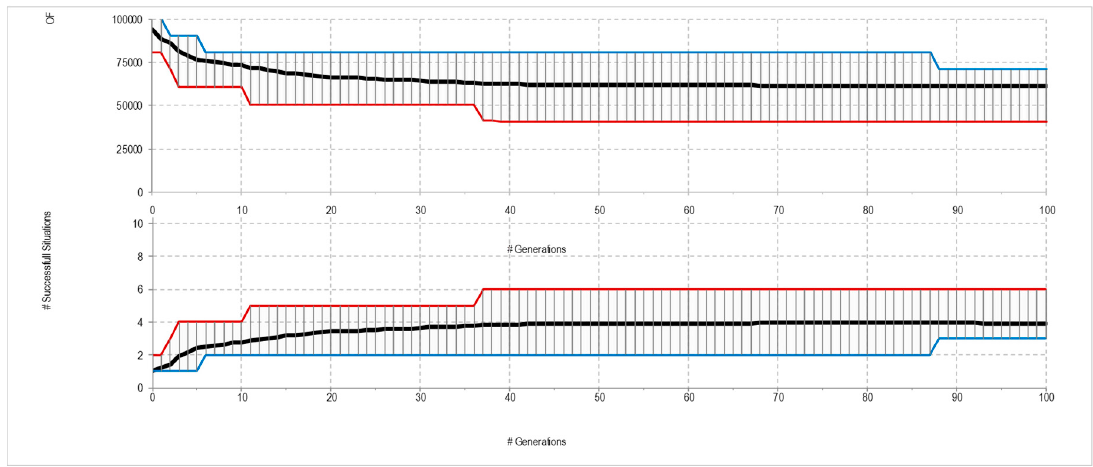
Figure 3. Convergence of the values of best objective function (OF, top ) and the number of successful situations ( bottom ) of 32 independent runs of the GA evolving the behavior of a team of predator agents with canonical morphology. The bold curves correspond to the mean, while the envelope shows the minimum and maximum values in each generation.